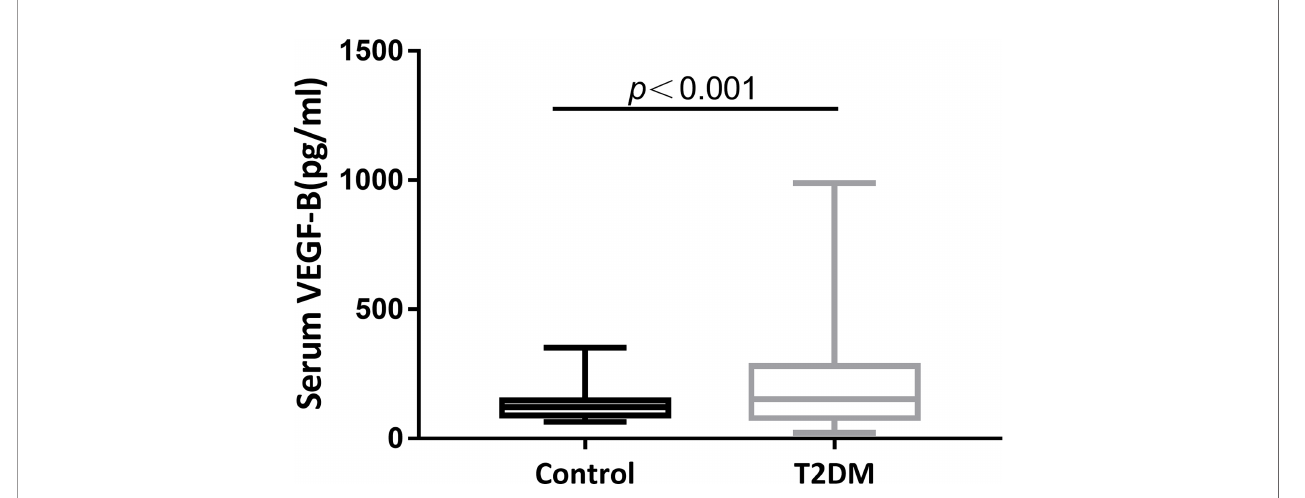
FIGURE 1 | Serum VEGF-B level elevates in T2DM patients. A signi fi cantly increase of serum VEGF-B levels in T2DM patients compared to healthy control subjects was observed ( p <